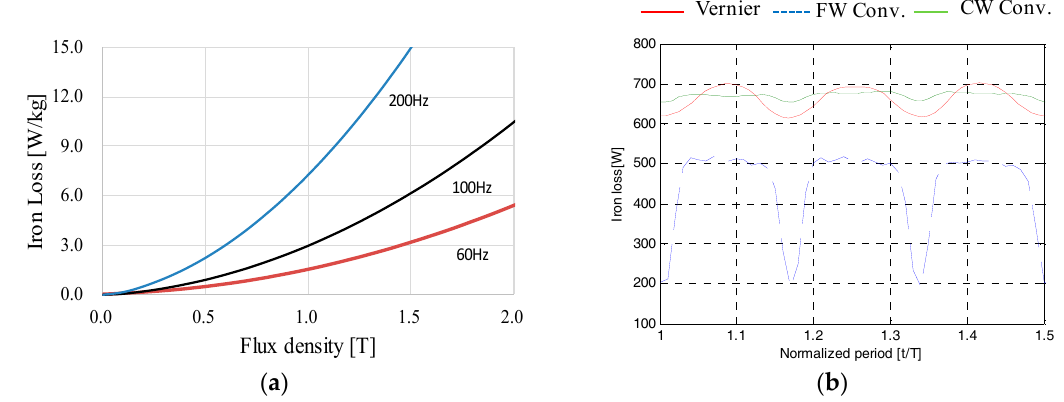
Figure 9. Si-steel loss properties and simulated core losses. ( a ) Iron losses of Si-steel with frequencies; ( b ) Iron losses.